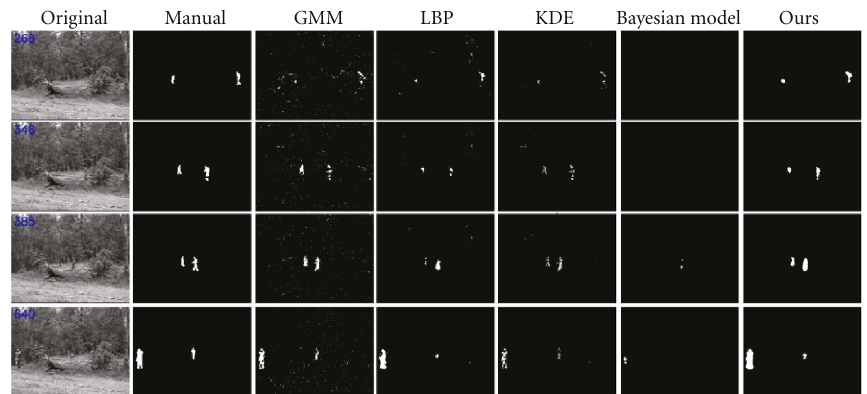
Figure 8: Qualitative comparison results of the five BGS algorithms on the Jump sequence. The first column contains the original video frames. The second column contains the corresponding ground truth frames. The last five columns contain the detection results of the GMM, LBP, KDE, Bayesian Model, and our method,